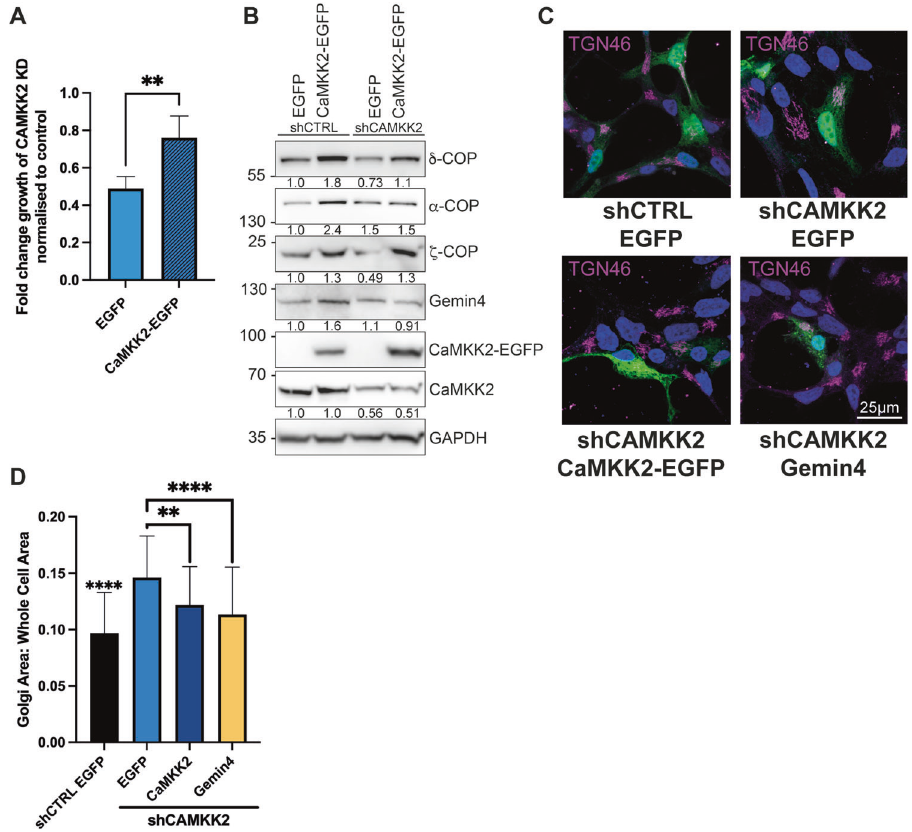
Fig. 6 CaMKK2 expression regulates COPI coatomer expression and its re-expression can rescue the growth defect and Golgi expansion observed in CAMKK2 knockdown cells. A LNCaP cells stably expressing control or CAMKK2-targeting shRNA were transfected with EGFP or CaMKK2-EGFP and cultured for 96 h. The growth of the CAMKK2 knockdown cells were normalised to control and the fold change to the seeding density was plotted. Mean ± SD; N = 5 with three technical repeats; ** P = 0.0017. B Control and CAMKK2 knockdown LNCaP cells were transiently transfected with control EGFP or CaMKK2-EGFP for 48 h, cells were harvested and cell extracts were subjected to western blots for COPI coat proteins. C Confocal images of control and CAMKK2 knockdown LNCaP cells transiently transfected with EGFP or CaMKK2-EGFP for 48 h, stained with TGN46 antibody and DAPI (nucleus). Scale bar = 25 µm (for all images). D Quanti fi cation of Golgi (TGN46-positive) area normalised to cell area of samples shown in C . The EGFP-control transfected CAMKK2 knockdown cells had a signi fi cantly ( P < 0.0001) larger Golgi area compared to the control. Mean ± SEM; **** P < 0.0001, ** P = 0.0017. Two independent experiments with a minimum of 20 cells per group were